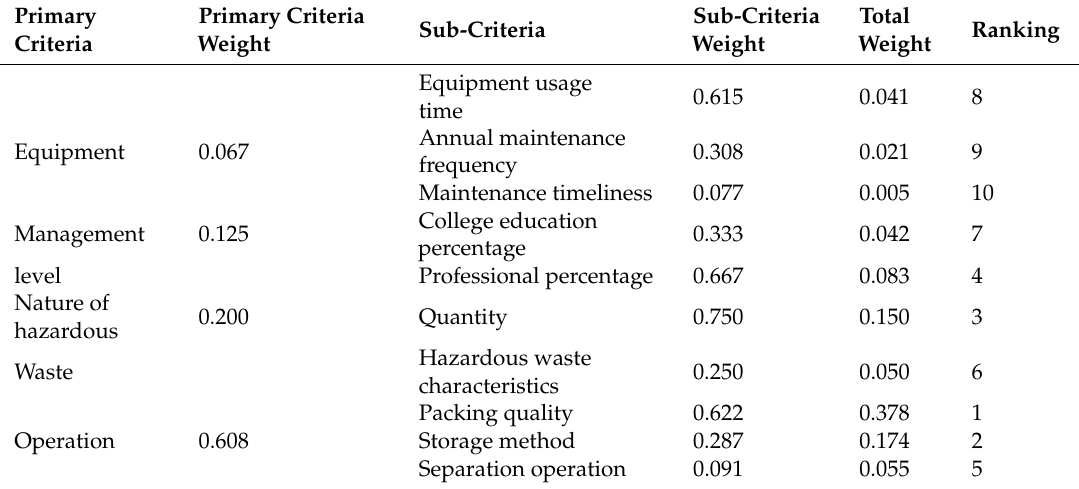
Table 5. Risk evaluation criteria weights.